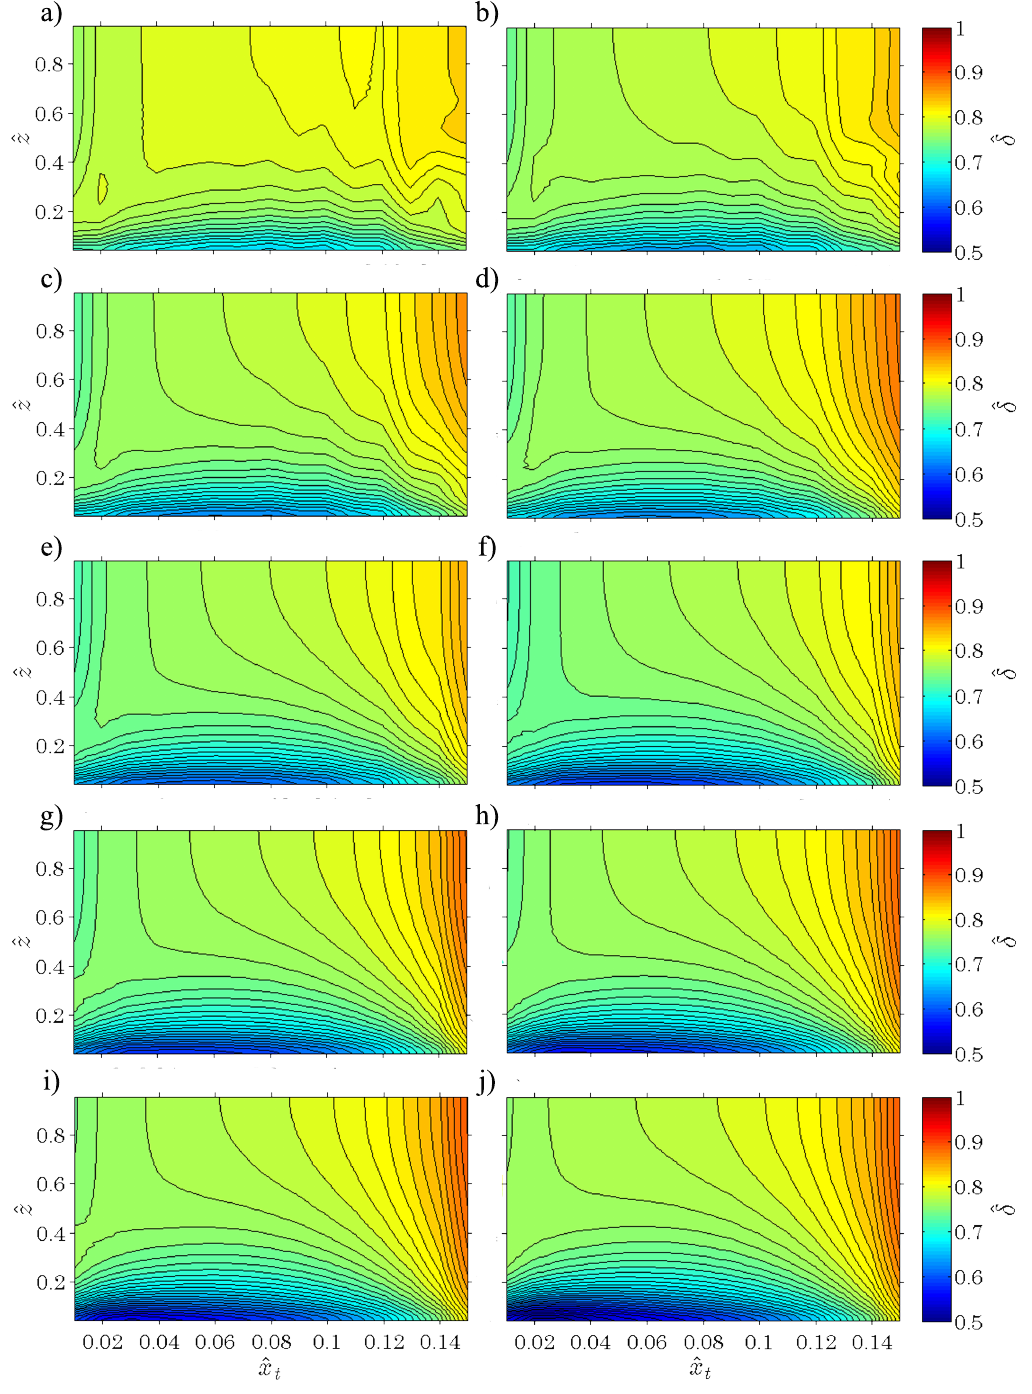
Figure 13. Distribution of the ˆ δ -angle at the tributary entrance for α equal to ( a ) 45 ◦ , ( b ) 50 ◦ , ( c ) 55 ◦ , ( d ) 60 ◦ , ( e ) 65 ◦ , ( f ) 70 ◦ , ( g ) 75 ◦ , ( h ) 80 ◦ , ( i ) 85 ◦ , ( j ) 90 ◦ . Here, ˆ x t = x t / B m is the non-dimensional abscissa directed in the streamwise direction centred in the upstream corner of the